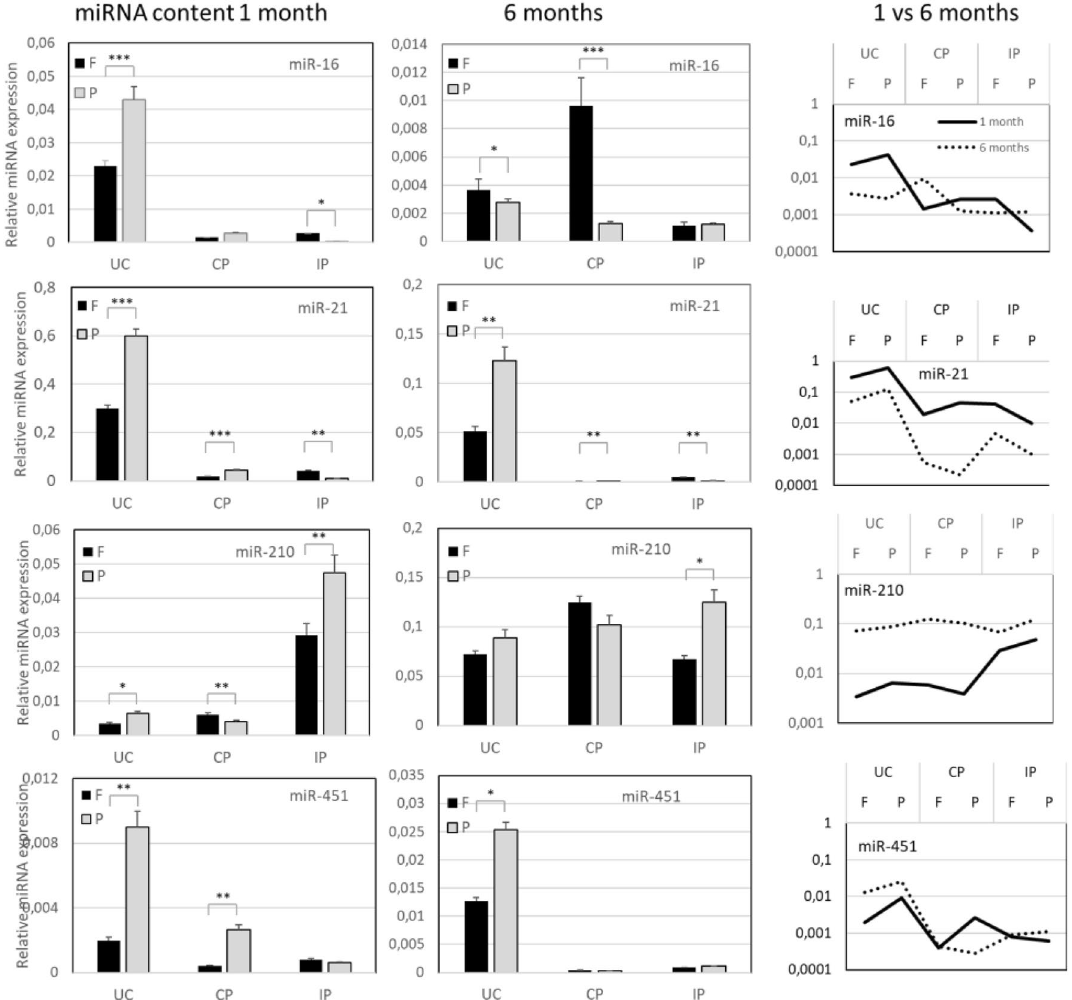
Figure 3. Quantification of EV miRNA content. Total RNA is extracted from EVs purified from healthy donor-obtained urine samples (N = 3), stored either preserved at room temperature (P) or frozen (F), using ultracentrifugation based protocol (UC), chemical precipitation (CP) or immuno-precipitation with anti-CD9 coated beads (IP). RT-qPCR amplification is performed of miRNAs de-scribed to be contained in EVs, namely miR-16, miR-21, miR-210 and miR.451. We show the average relative miRNA expression from three biological replicates. Relative expression was calculated with respect to a reference sample with known and constant RNA input (EV RNA from LnCAP cell culture). Samples from three healthy donors, and 2 independently processed aliquots from each donor, are included in the assessment. 1-way ANOVA and Bonferroni post-hoc test were used to determine statistical significance of observed differences * indicates p-value < 0.05, ** p-value < 0.01 and *** p-value <